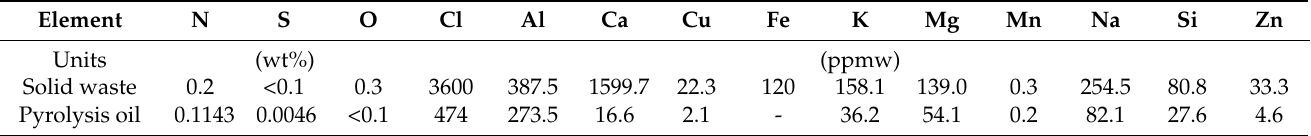
Table 4. Elemental composition of solid waste and pyrolysis oil